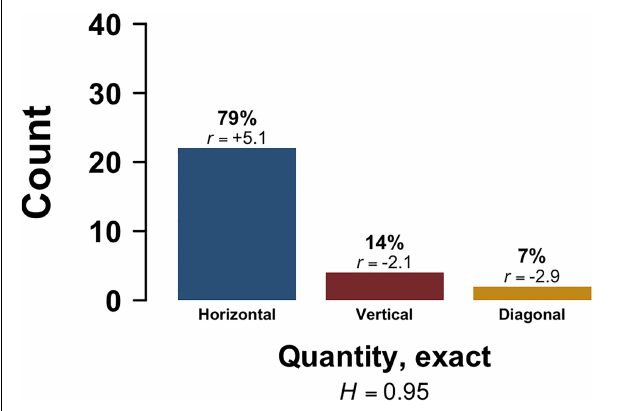
FIGURE 4 | Experiment 3: Dominant Orientation (horizontal, vertical, diagonal) for the exact quantity task (placing the numerals 2, 4, 7, and 9); r indicates adjusted standardized Pearson residuals, and H indicates Shannon entropy scores, both of which are based on only the data from this